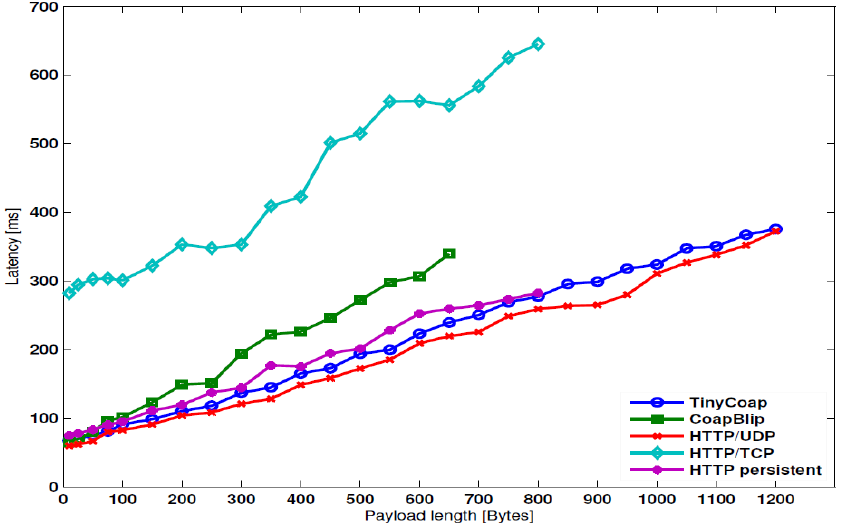
Figure 6. Latency evolution according to the payload size. The performance of HTTP increases significantly if a TCP persistent connection is